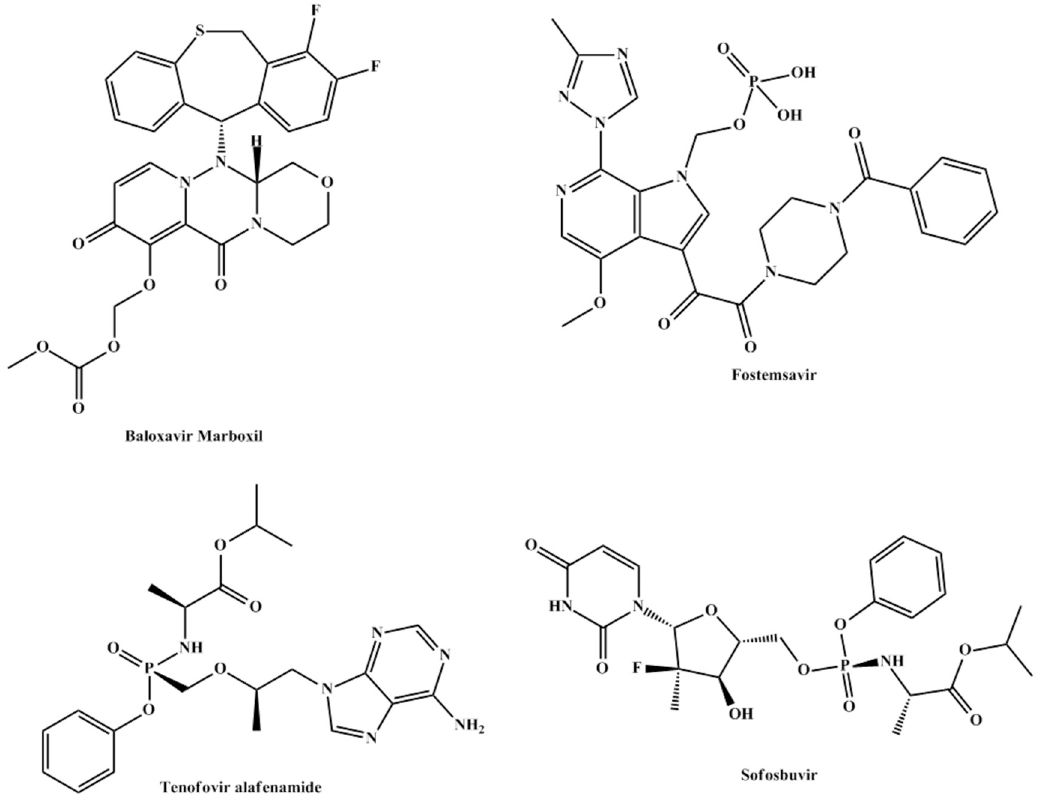
Figure 4. Structures of prodrugs reported in this sub-section.